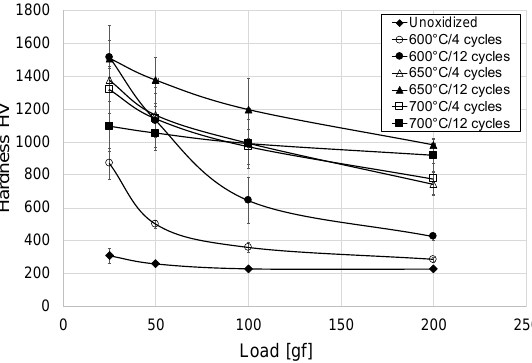
Figure 12. Surface hardness of oxide scales formed at different applied parameters of cyclic oxidation, depending on indenter load.